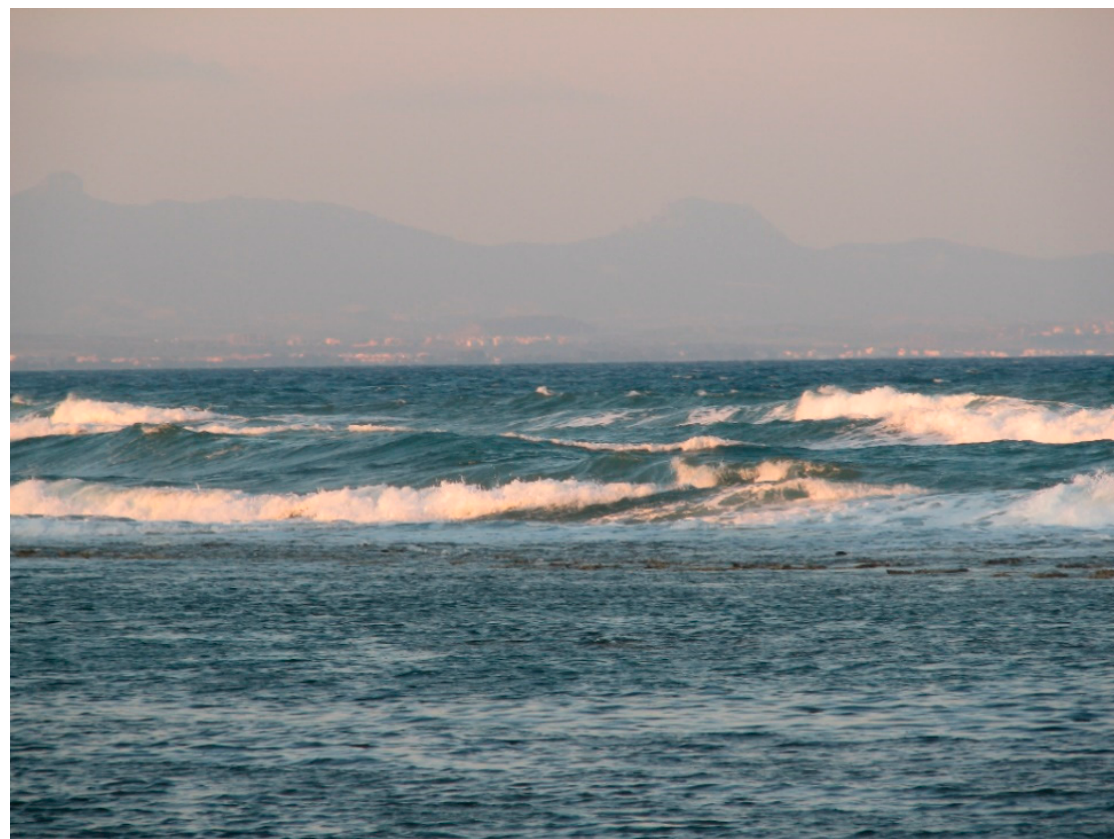
Figure 5. A “sailor’s-eye” view of the sea and coastline at the modern Salamis archaeological site looking to the northeast towards the Karpass Peninsula. Photograph by J.M. Gordon.